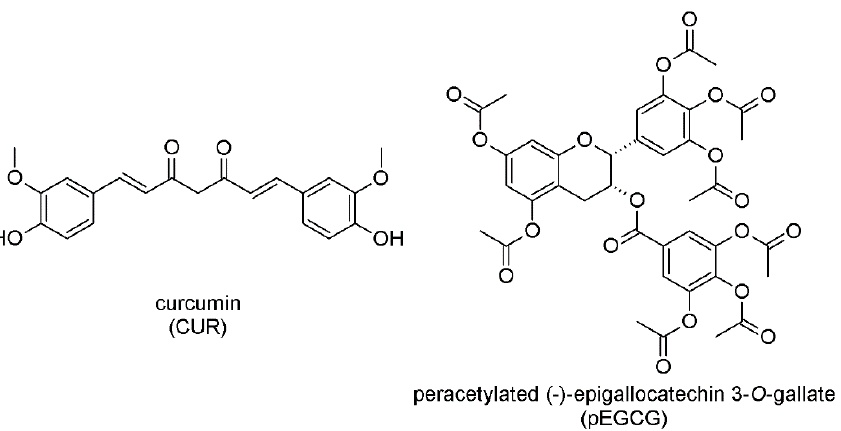
Figure 1. Chemical structures of curcumin ((1E,6E)-1,7-bis(4-hydroxy-3-methoxyphenyl)hepta-1,6- diene-3,5-dione; CUR) and peracetylated EGCG (3 ′ ,3 ″ ,4, 4 ″ , 5, 5 ″ ,7- O -octaacetyl-( − )-epigallocatechin 3- O -gallate; pEGCG).